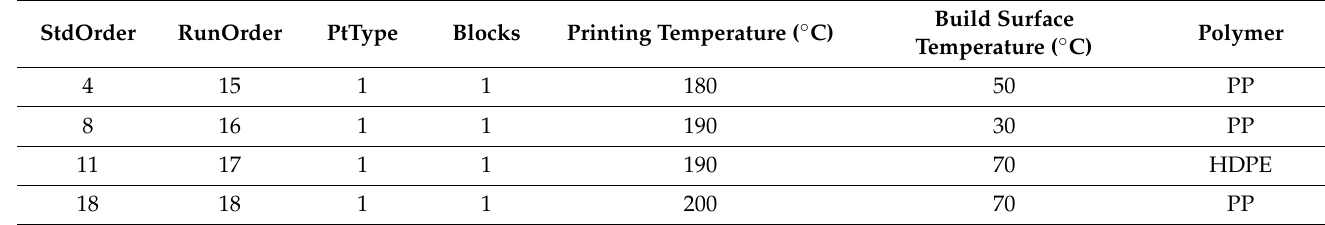
Figure 1. Pellet 3D printer was selected to avoid thermal degradation of raw material in process of filament extrusion (melt blending) [24].